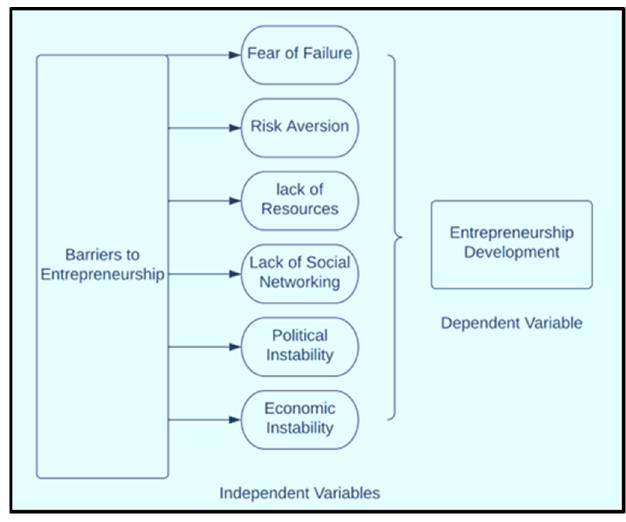
Figure 1. Conceptual Framework.